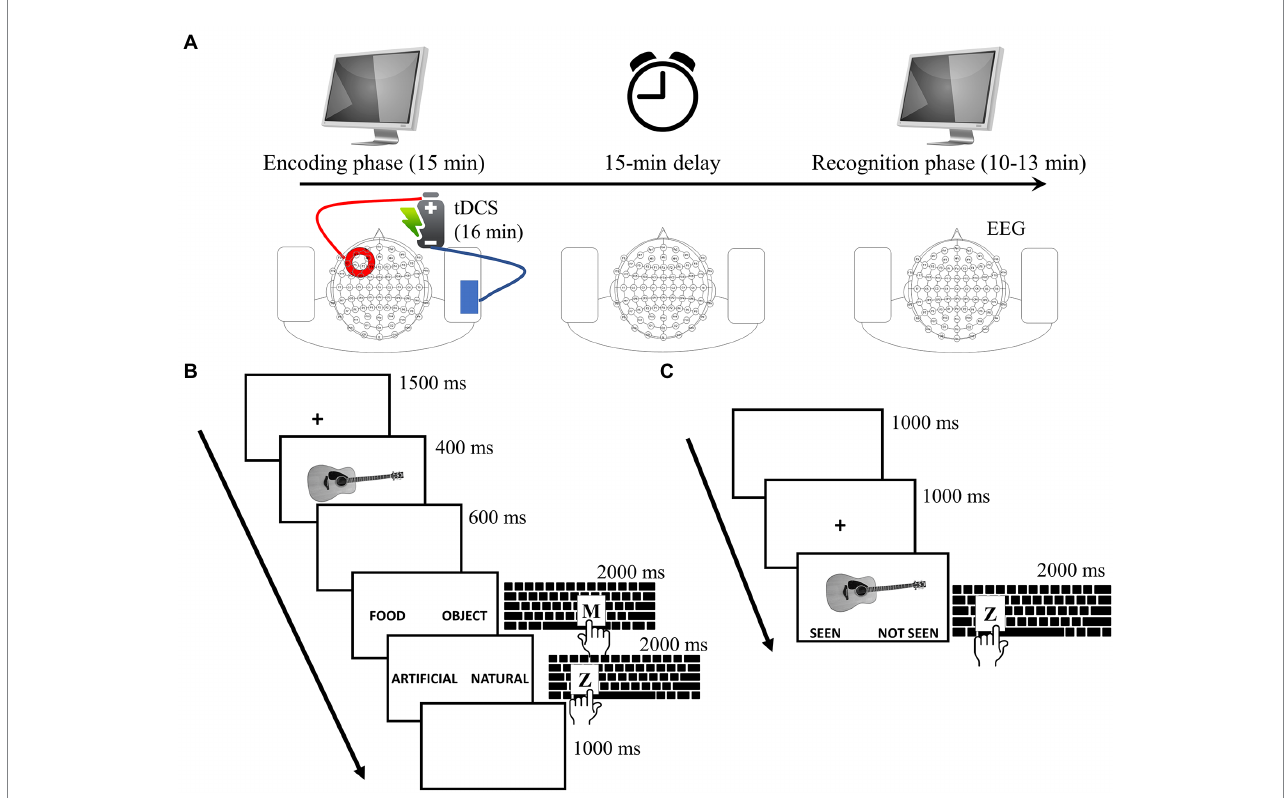
FIGURE 1 Experimental procedures. (A) Anodal or sham tDCS was administered during the encoding phase of the episodic memory (EM) task. After a delay of 15 min, participants performed the recognition phase of the EM task during which EEG data were collected. (B) Trial procedure of the encoding phase of the EM task. In each trial, an image to be remembered is presented followed by two different semantic choices. The original task was performed in Italian. (C) Trial procedure of the recognition phase of the EM task. Participants are required to decide whether each image was old (already seen in the encoding phase) or new (not seen). The original task was performed in